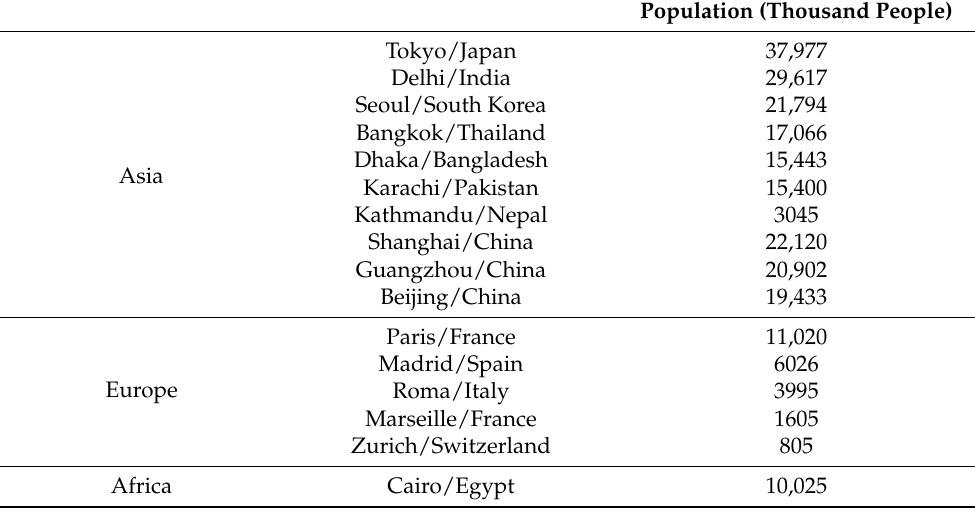
Table 2. List of metro city populations in this study. Data are based on Demographia World Urban Area